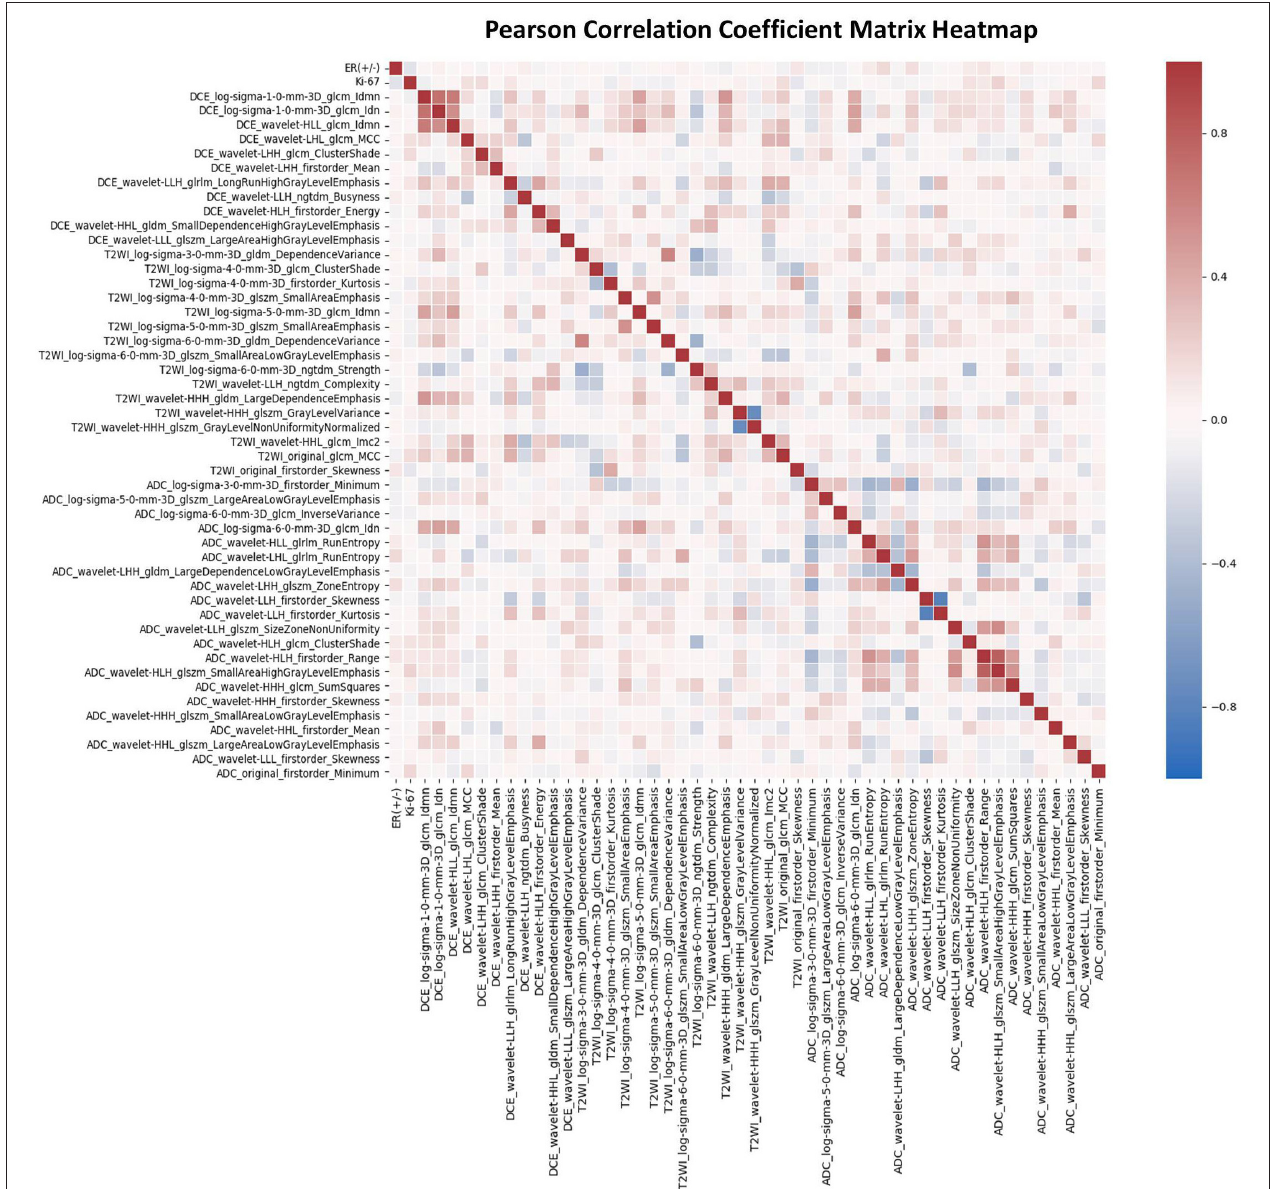
FIGURE 3 | The Pearson’s correlation coefficient matrix of the selected features. Red color denotes positive correlation, blue denotes a negative correlation, and the shade of the color indicates the correlation intensity.